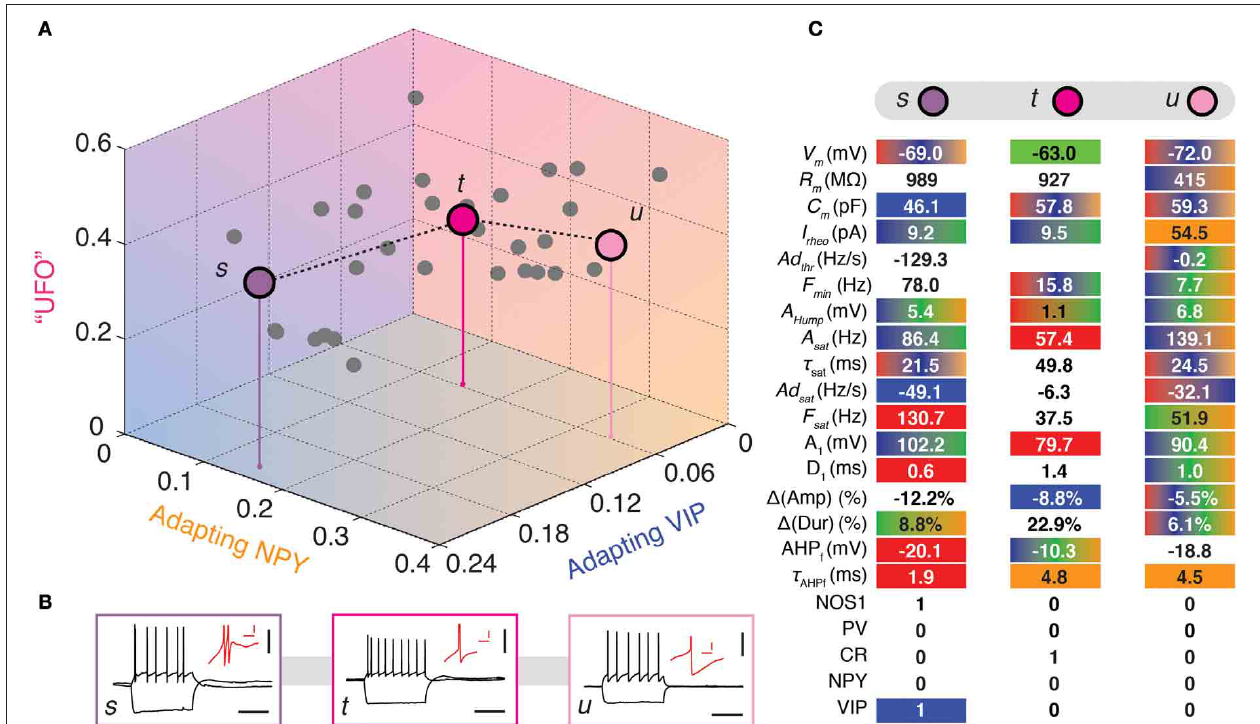
rheobase current and to a 100pA hyperpolarizing current pulse (black traces, scale bars 50mV, 400ms). Insets: details of the repolarization phase of the first spike (red traces, scale bars 5mV, 20ms). (C) Table summarizing 17 electrophysiological and 5 molecular properties reminiscent of FS-PV (Red), Adapting VIP (blue), Adapting SOM (Green), or Adapting NPY (orange) archetypes in three different UFOs. Colored backgrounds indicate values falling in ranges typical for an archetype. Gradient backgrounds indicate values falling in a range typical for multiple